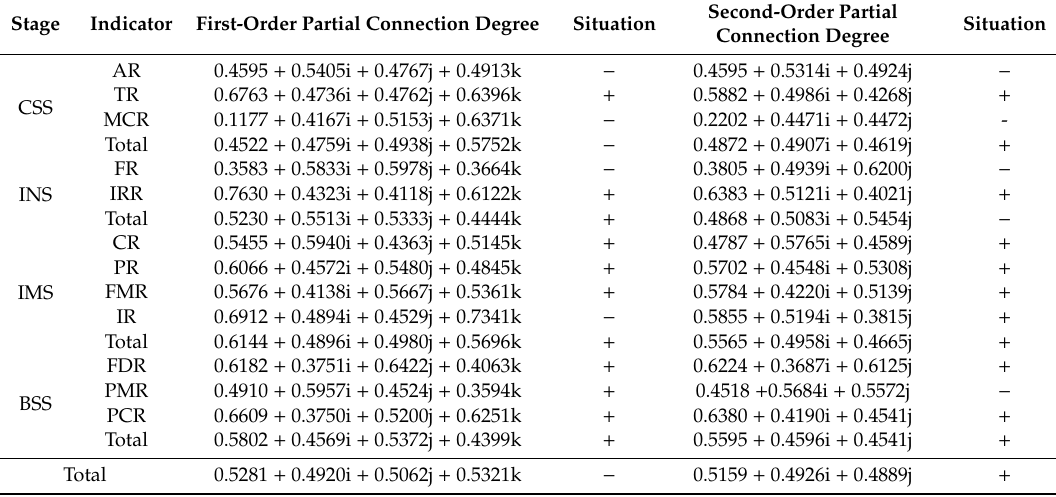
Table 6. Calculation of partial connection degree and trend